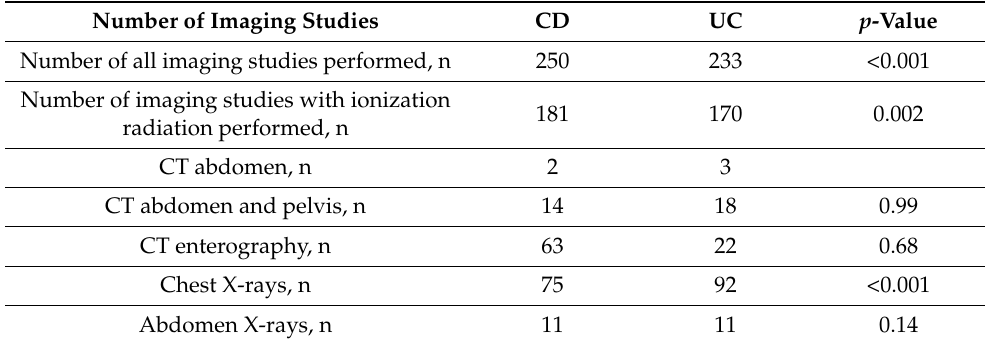
Table 3. Number of imaging studies performed.